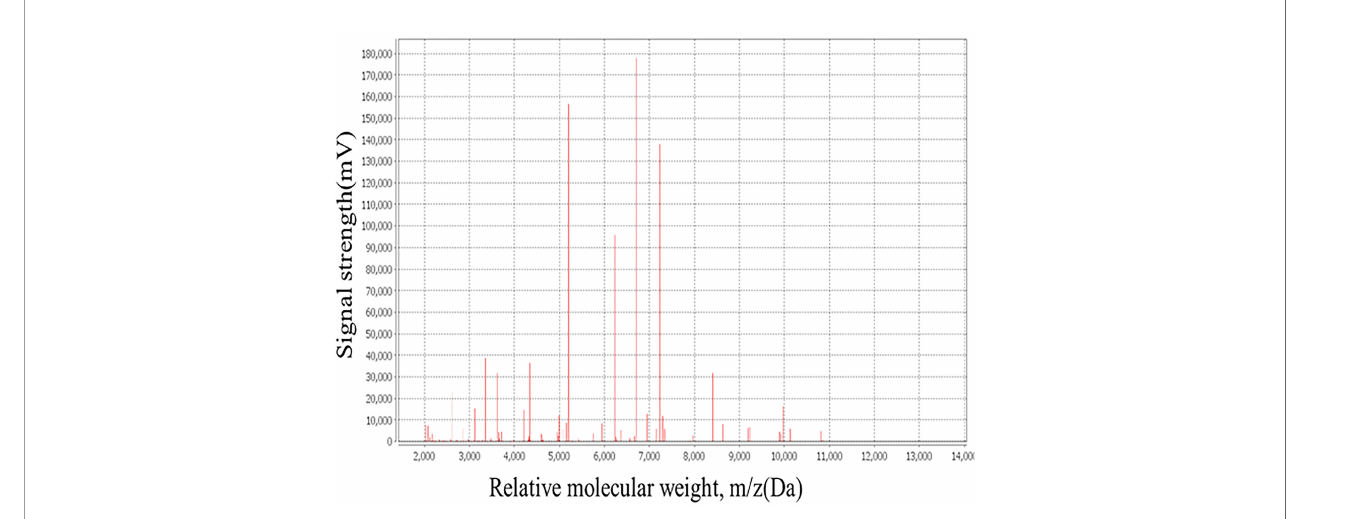
FIGURE 3 | The mass spectra of H. huttiense revealed high